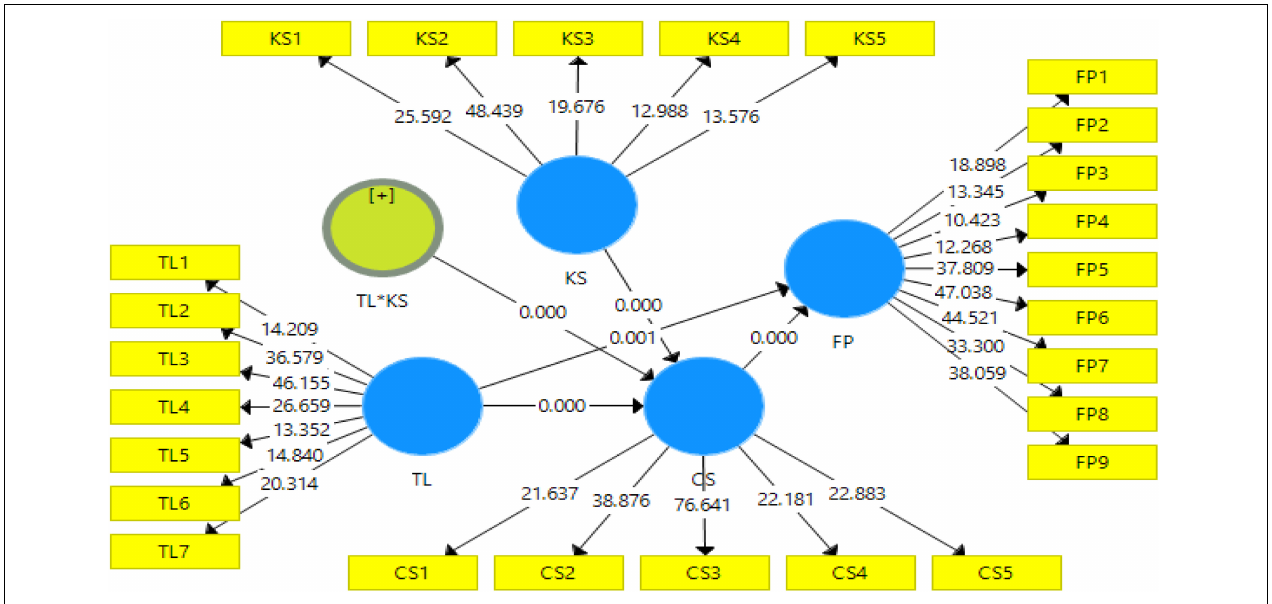
FIGURE 1 | Structural model assessment.